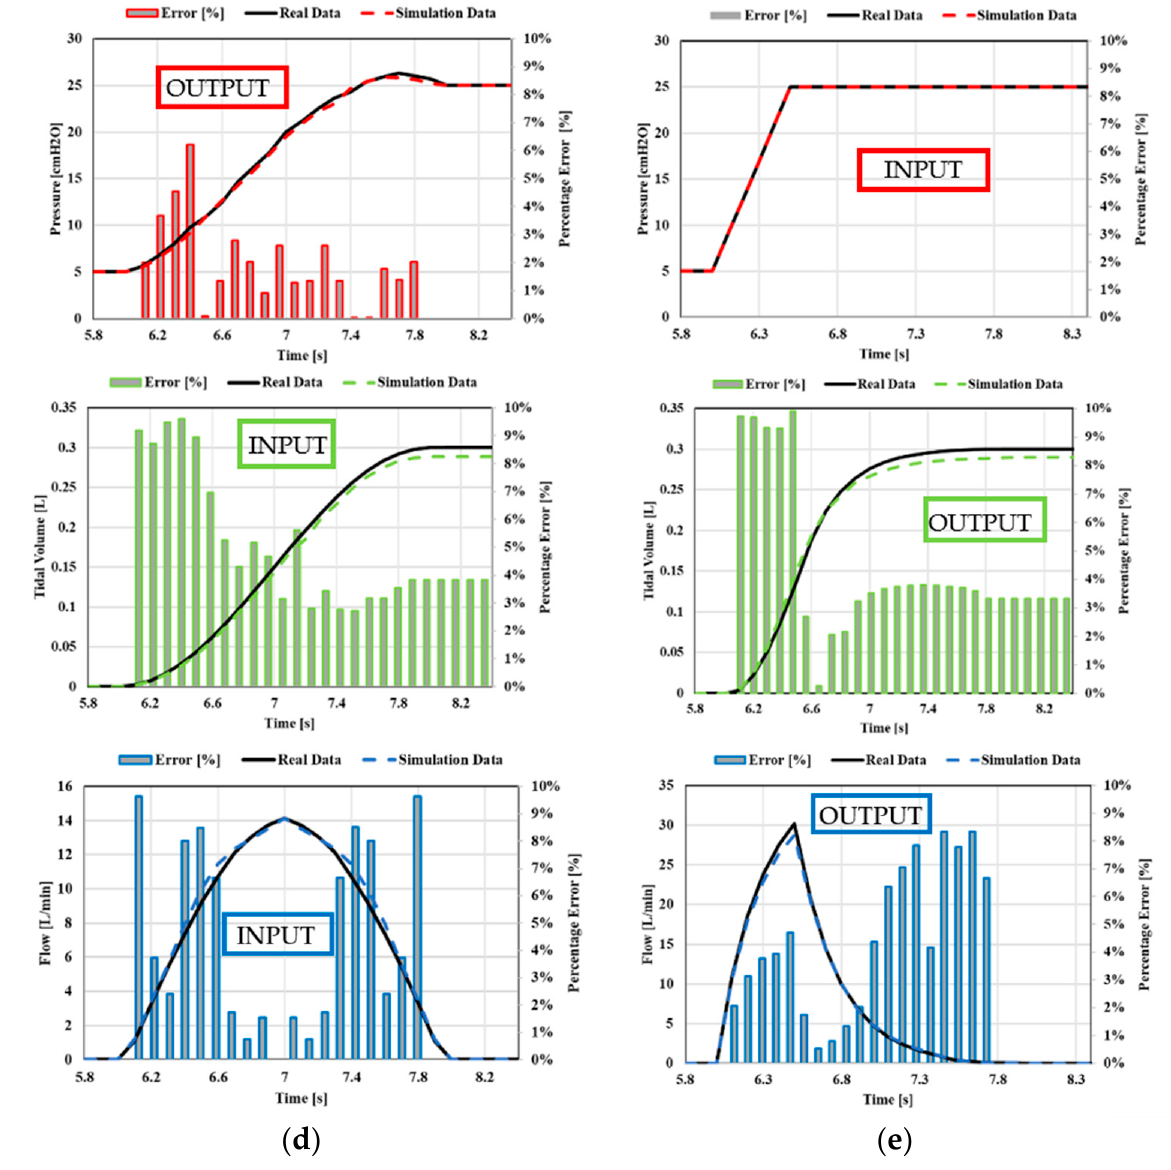
Figure 22. Case 1. Comparison between real ‐ life data and simulation data: ( a ) square flow, ( b ) half decelerating; ( c ) full decelerating; ( d ) sine waveform; ( e ) ramp pressure.